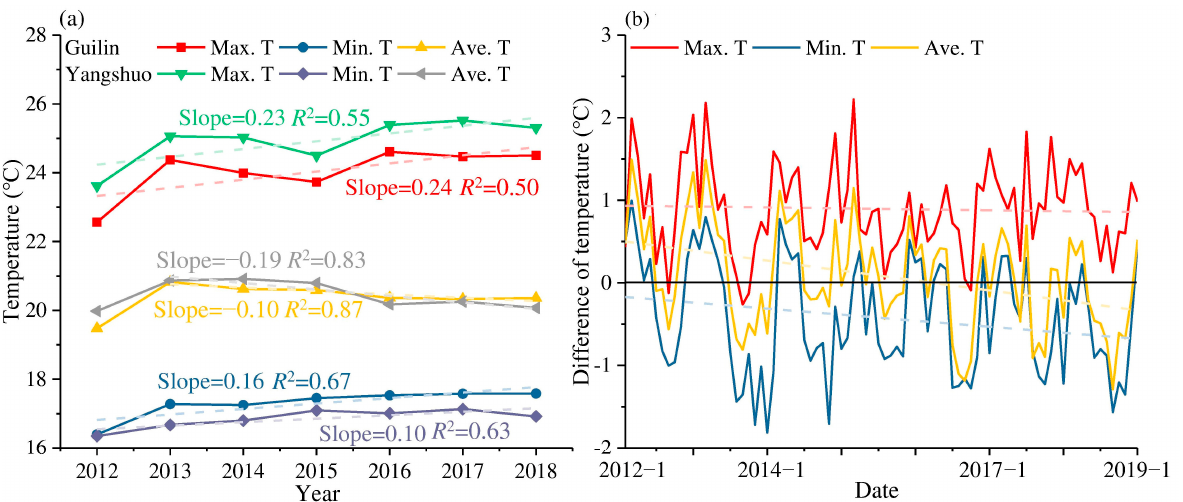
Figure 2. Characteristics of air temperature changes in Guilin and Yangshuo stations, ( a ) Air temper- ature, and ( b ) Temperature difference between Guilin and